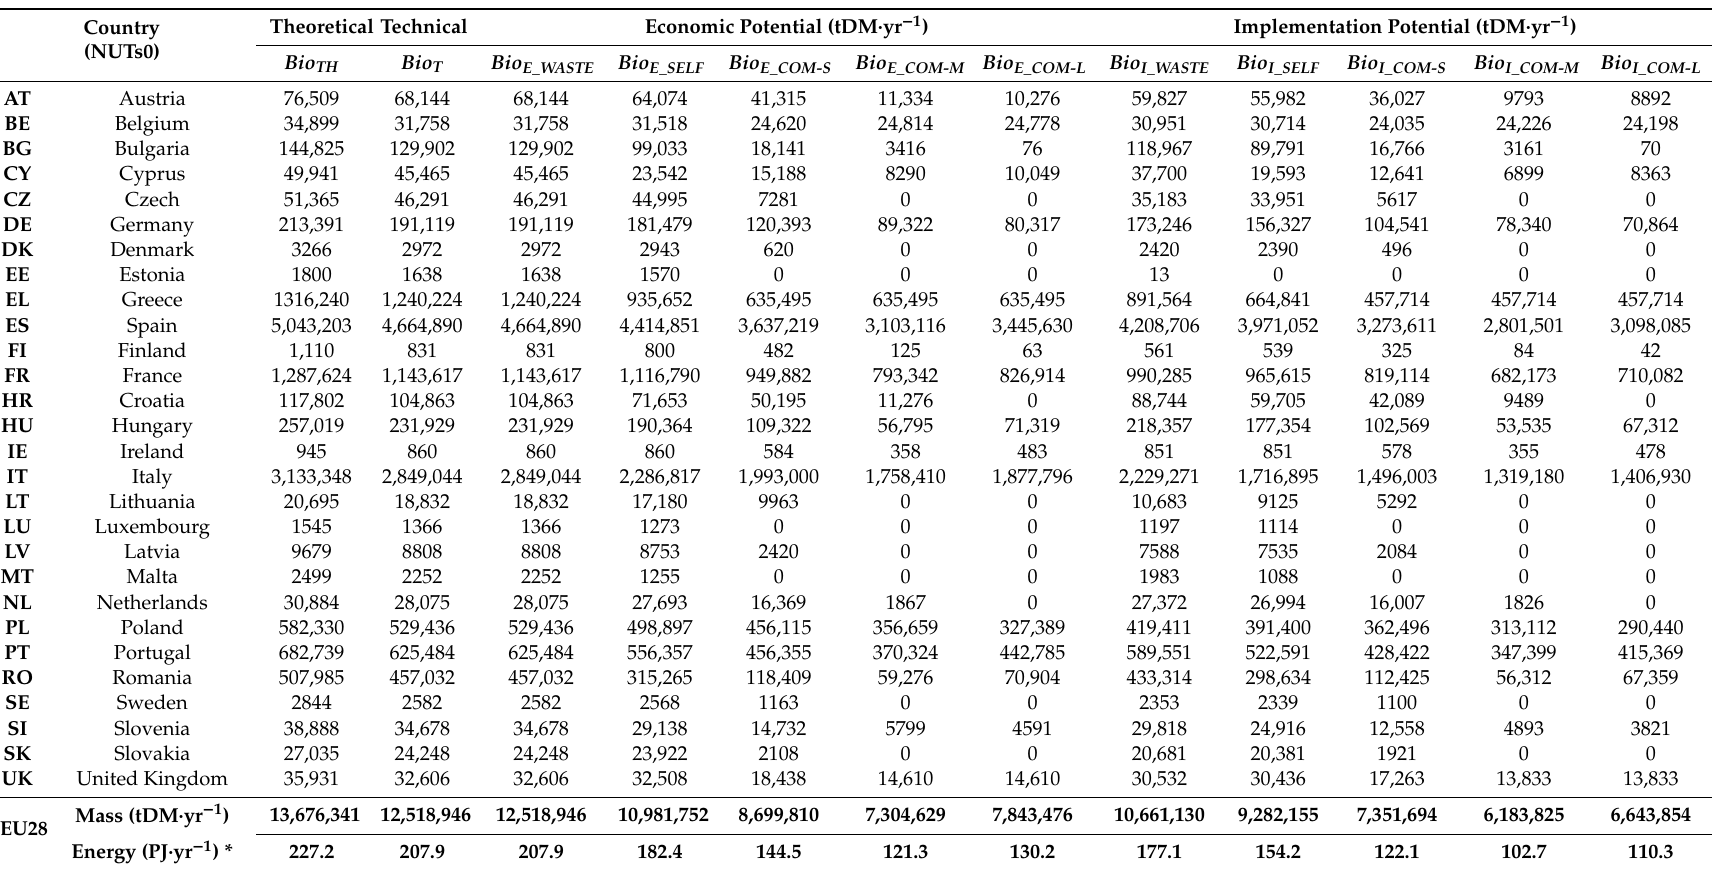
Table 7. Summary of total agricultural pruning biomass potential: theoretical, technical, economic and implementation (mass and energy units). Country (NUTs0)